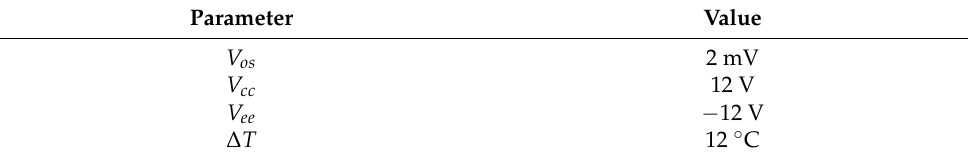
Table 12. Other parameters in the CTD